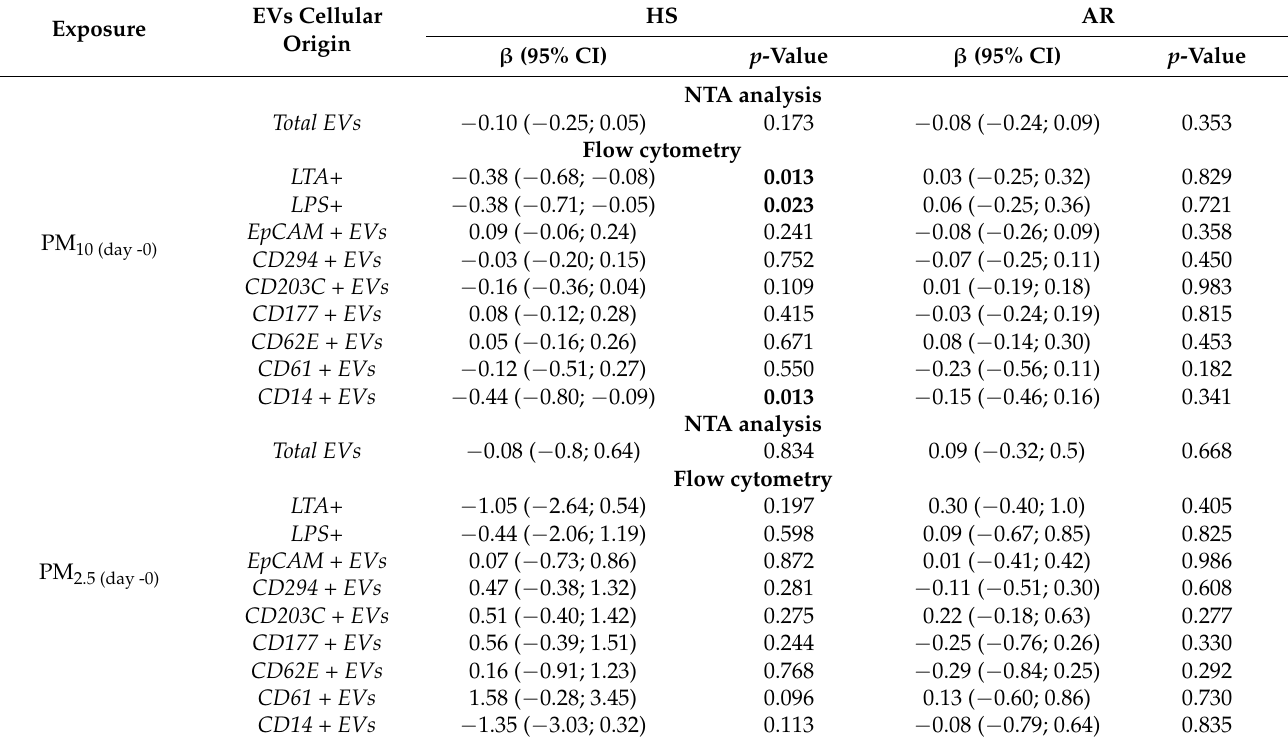
Table 3. Association between PM 10 and PM 2.5 exposure (day -0) and EVs released by different cell types.